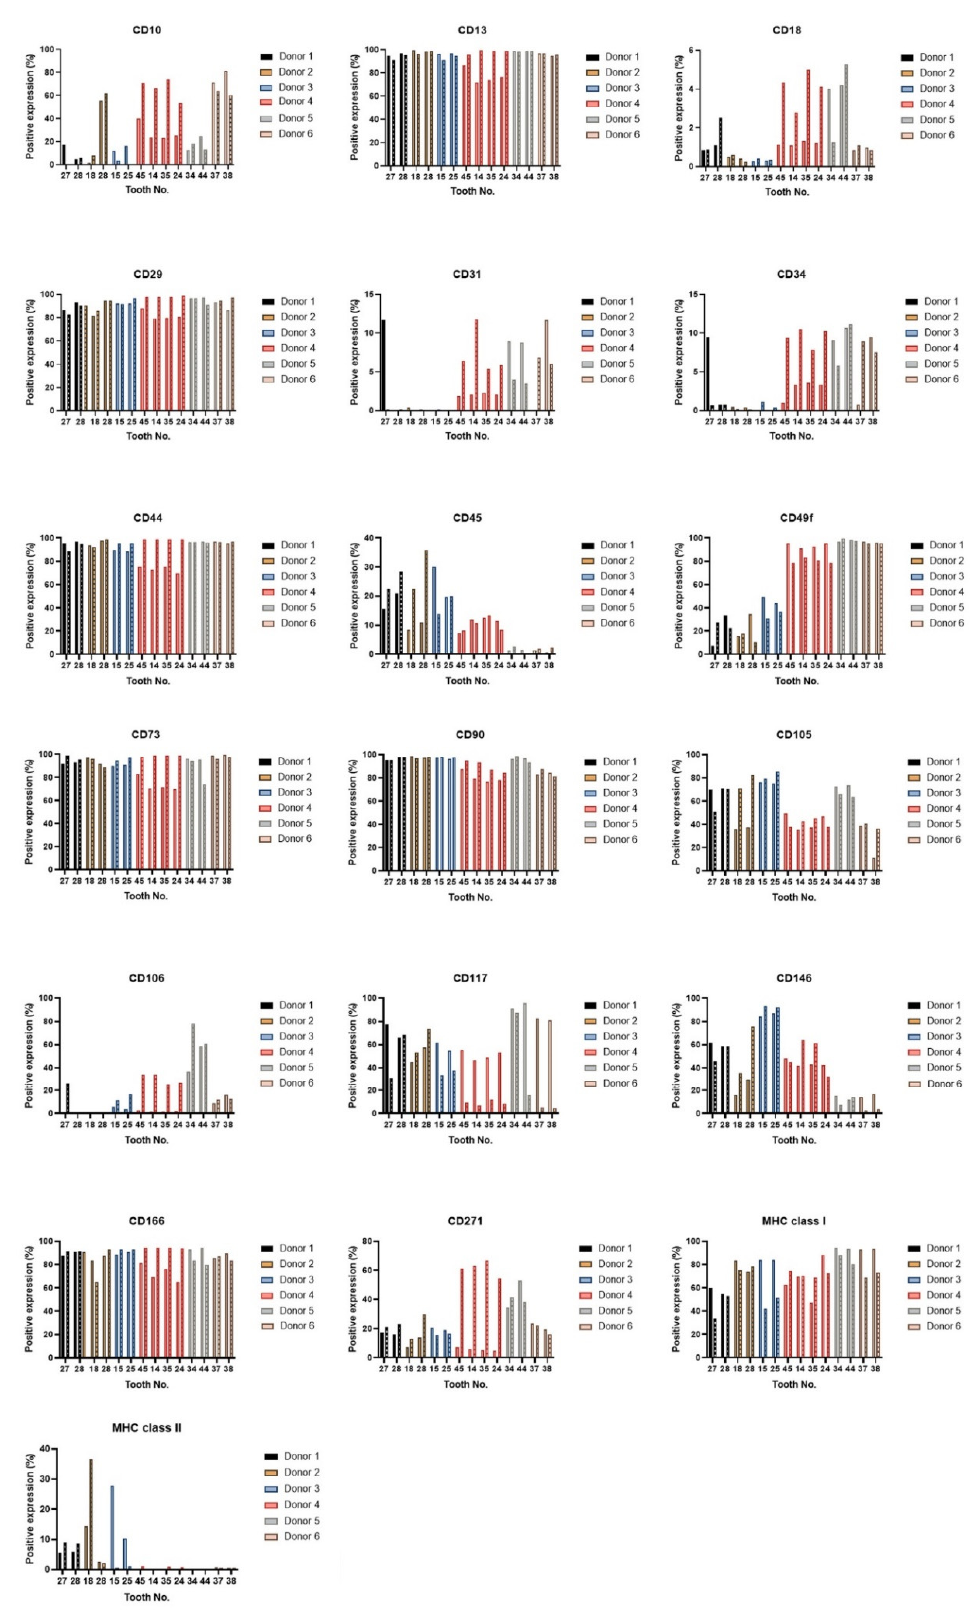
Figure 5. Immunophenotype profile of all paired lineages in the 3rd and 7th passages. Data for the 7th passage are depicted as boxes filled with patterns. The layouts of graphs illustrate